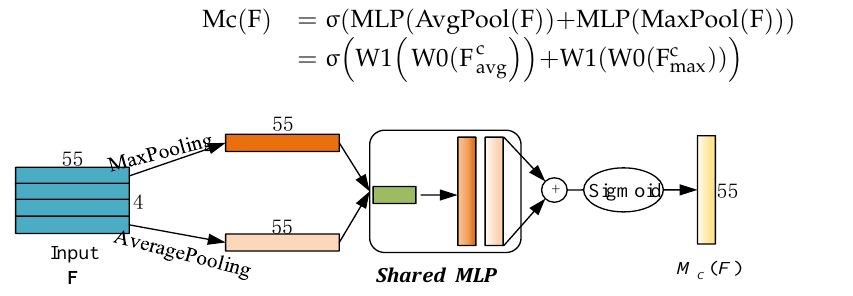
Figure 6 . CAM structure diagram Figure 6. CAM structure diagram.